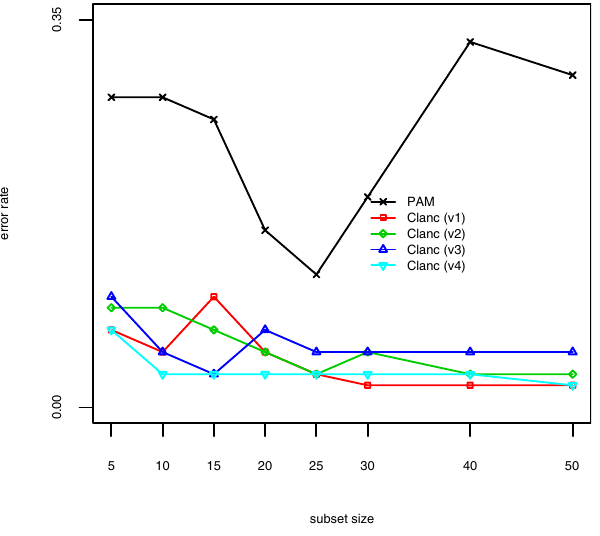
Figure 3. Results for NCI data. Classifiers are identical to those in Tables 3 and 4, with Clanc v1-v4 corresponding to the last four variants reported there, respectively.